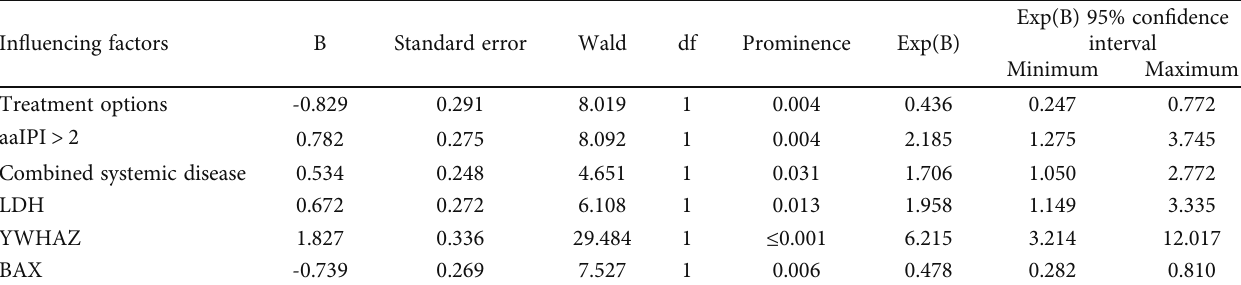
Figure 4: Univariate analysis of patients with di ff use large B cell lymphoma among various groups. (a) The cut-o ff value of PD-L1 was 5%. (b) The cut-o ff value of PD-L1 was 10%. (c) The cut-o ff value of PD-L1 was 15%. (d) The cut-o ff value of PD-L1 was 20%. Table 4: Multivariate Cox regression